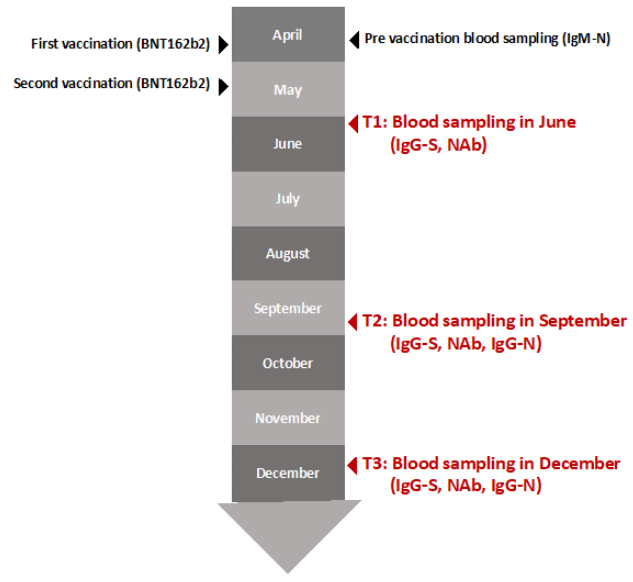
Figure 1. Time schedule for blood sampling from the participants.